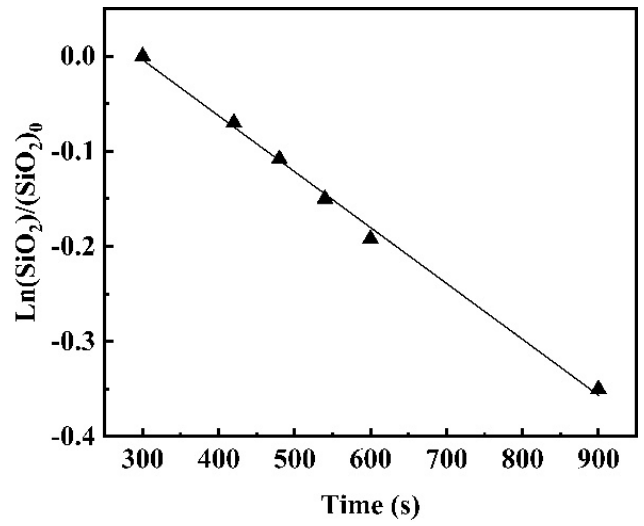
Figure 20. Relationship between interfacial area integral and logarithm of SiO 2 concentration during the reaction of Fe-13Mn-5Al with low SiO 2 slag.